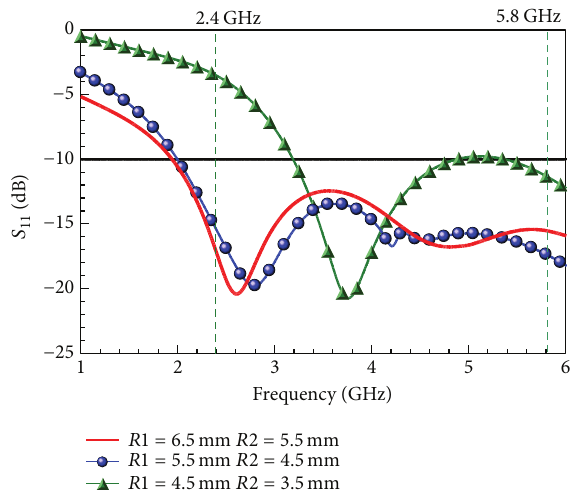
Figure 6: Simulated S 11 for different loop sizes of the proposed antenna.